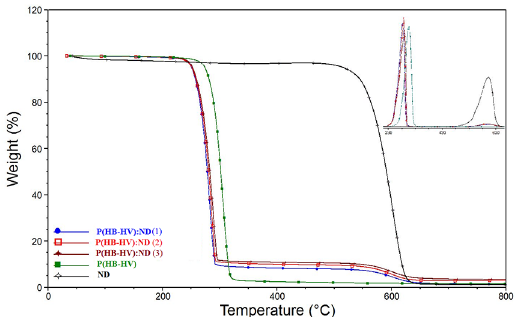
Figure 3. TGA curves of P(HB-HV)-C (filled square), P(HB- HV):ND microcapsules (filled circle, filled star, unfilled square), and ND (unfilled star).